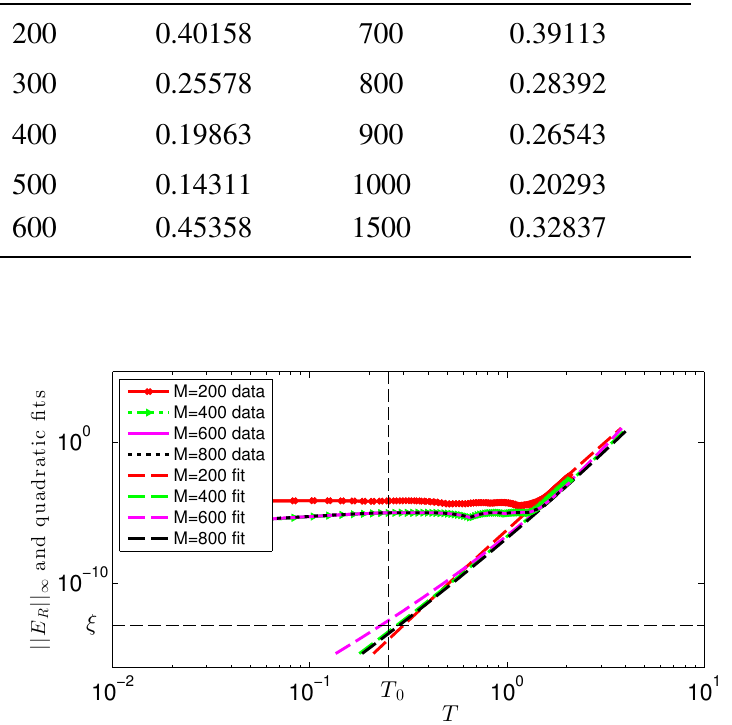
|| Figure 8. || E in the four-pole example with the added perturbation 10 − 5 sin(10 πx ) and R ∞ M = 200 , 400, 600 and 800 together with their extrapolated quadratic fits constructed using more narrow fitting region. The vertical dashed line indicates the exact time delay T while the horizontal dashed line indicates the level of filtering of singular values given by ξ = 10 − 13